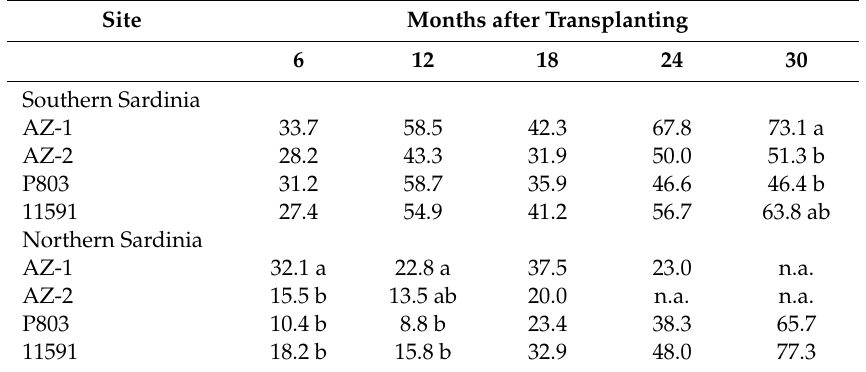
Table 3. Plant width (cm) of guayule lines from transplanting to harvest at 30 months at the two sites. Site